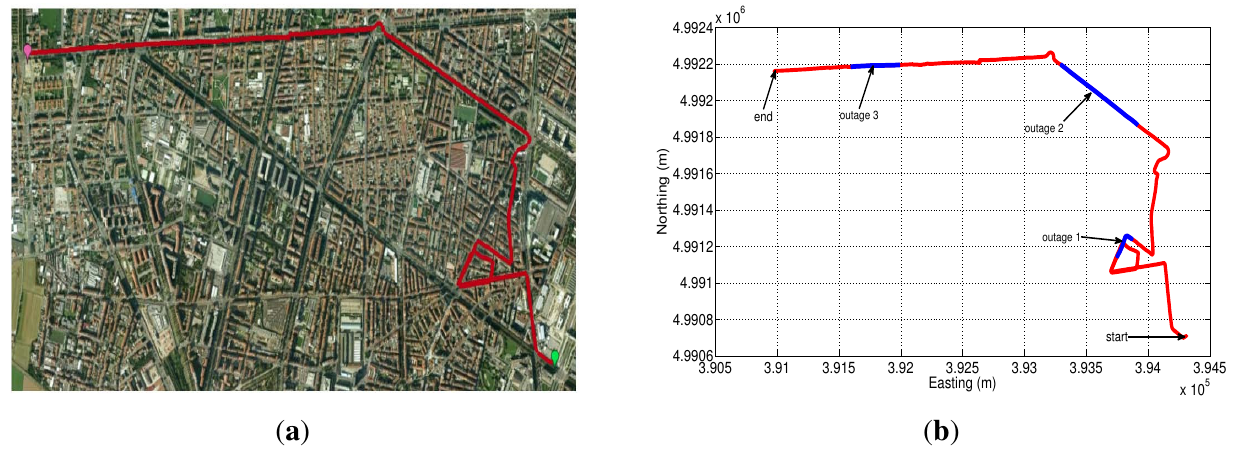
Figure 20. ( a ) First trajectory test in Google Earth; ( b ) first trajectory test in Matlab with the GPS outages that were introduced